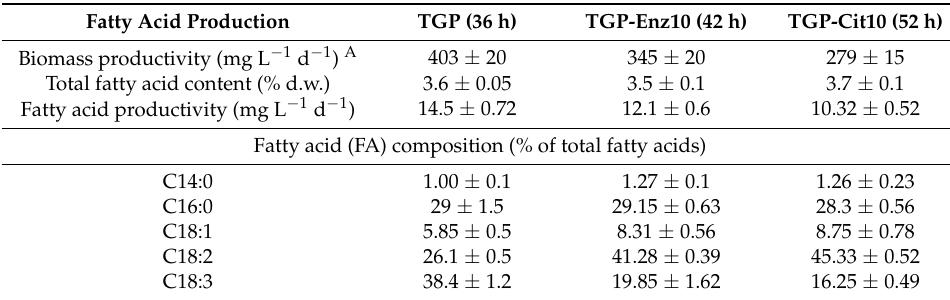
Table 1. Biomass productivity, total fatty acid (FA) content, fatty acid productivity and fatty acid composition in Chlorella cultures cultivated on 1 g/L glucose (TGP), wood enzymatic 10% hydrolysate containing 1 g/L glucose (TGP-Enz10), and 1 g/L glucose supplemented with 10% neutralized citrate buffer loading (TGP-Cit10). Cultivation conditions: photobioreactor under heterotrophic mode (0 µ E m − 2 s − 1 ) at 25 ◦ C. Number of independent experiments: 3. Fatty Acid Production